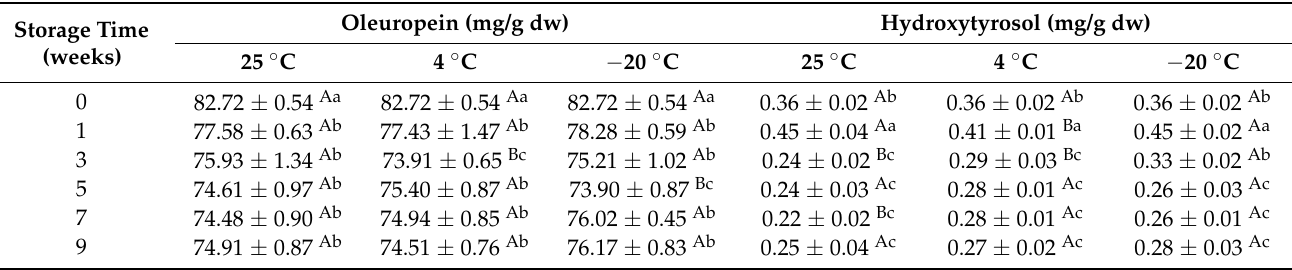
Table 6. Contents of oleuropein and hydroxytyrosol in olive leaf powder after storage at − 20, 4 and 25 ◦ C for different time